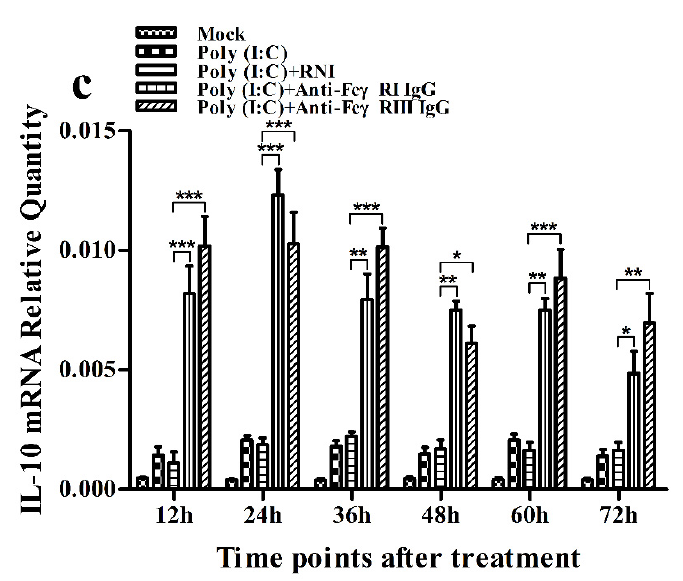
Figure 11. Effect of Fc γ RI or Fc γ RIII on poly (I:C)-induced mRNA expression of cytokines in porcine AMs. Relative quantitative RT-PCR analysis of cytokine mRNA levels in poly (I:C)-stimulated cells pretreated with RNI, anti-Fc γ RI IgG or anti-Fc γ RIII IgG. ( a ) IFN- α mRNAl evel, ( b ) TNF- α mRNA level, ( c ) IL-10 mRNA level. *** p < 0.001, ** p < 0.01, * p < 0.05.